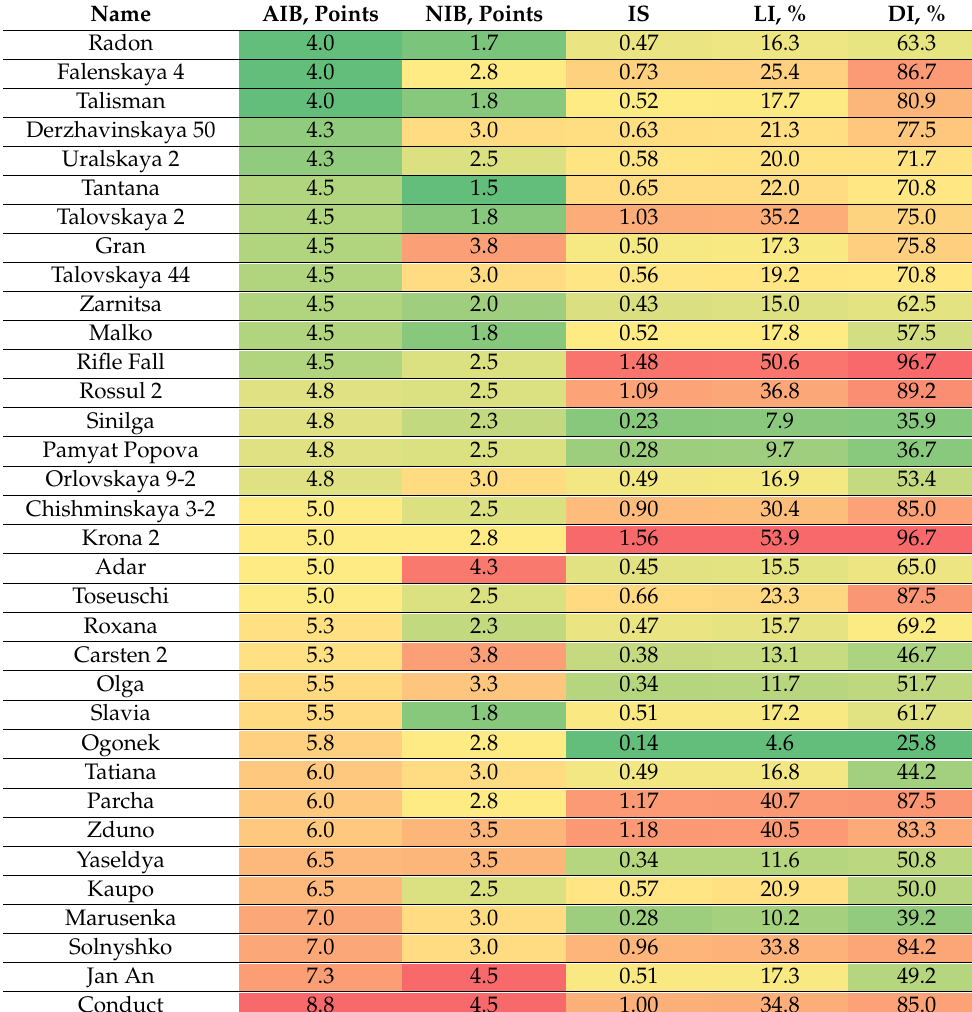
Table 4. Mean values of snow mold damage of rye accessions under a natural infection background (NIB) and an artificially-enriched infection background (AIB) in the field, as well as index susceptibil- ity (IS), mean percent of leaf infestation (LI), and mean percent of disease incidence (DI), determined using a detached leaf assay following Microdochium nivale